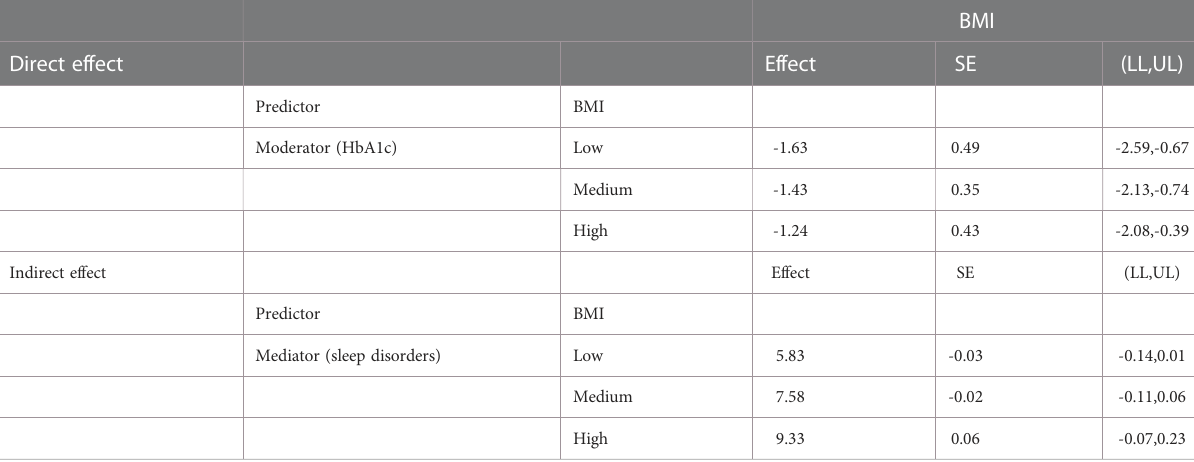
TABLE 12 Bootstrapped conditional direct and indirect